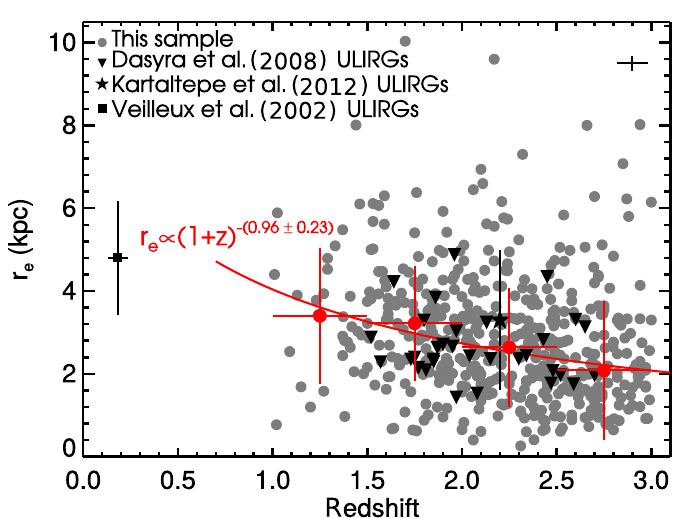
Fig. 4. Evolution of the sizes r e with redshift in our ULIRGs sample. Red solid circles represent the median sizes of ULIRGs in different redshift bins (∆ z = 0 : 5). Red line is the best fit to the four median points ( r e / (1 + z ) − (0 : 96 ± 0 : 23) ). The sizes of ULIRGs from the literature (Veilleux et al. 2002; Dasyra et al. 2008; Kartaltepe et al. 2012) are also plotted in this figure. Typical error bars for the data points are shown in the upper-right